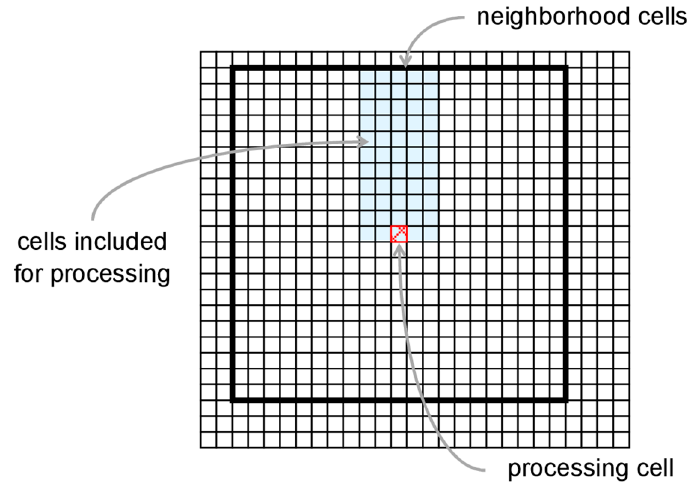
Figure 5. Focal method. Each cell is a 50 m × 50 m square (0.25 km 2 ). Cells colored in light blue correspond to those considered in the calculation of the mean percentage of PSZ extent, attributed to the cell colored in red.